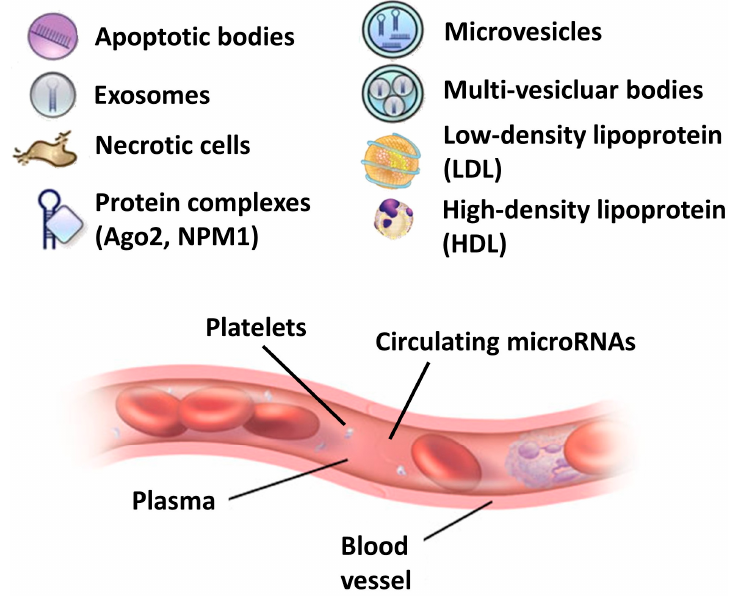
Figure 1. Different species of circulating MicroRNAs (miRNAs) in the bloodstream.